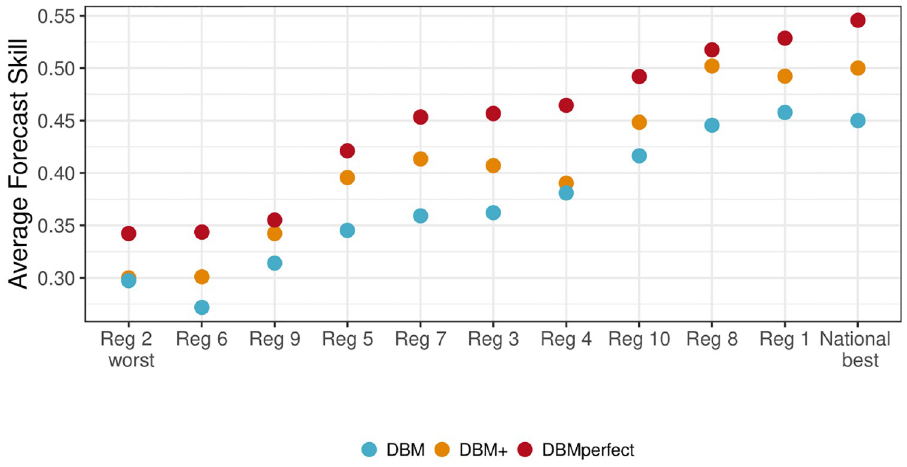
Fig 9. Average forecast skill by region, averaged over all seasons and targets ( s m , r ,.,.,. ). Regions are ordered by increasing DBMperfect average forecast skill. For all regions, DBM has the lowest average forecast skill, followed by DBM+ and DBMperfect,